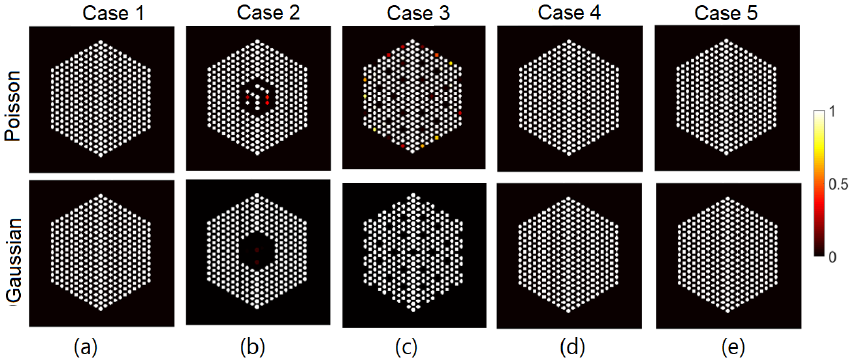
Figure 19. The FULL response matrix: probability of presence of pins using the proposed approach. ( a ) Case “1”; ( b ) Case “2”, ( c ) Case “3”, ( d ) Case “4”, and ( e ) Case “5”.